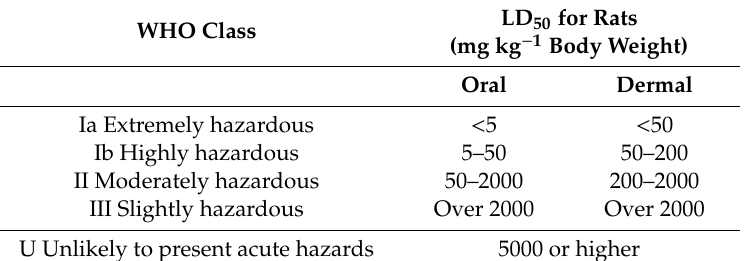
Table 1. Classification of pesticides by